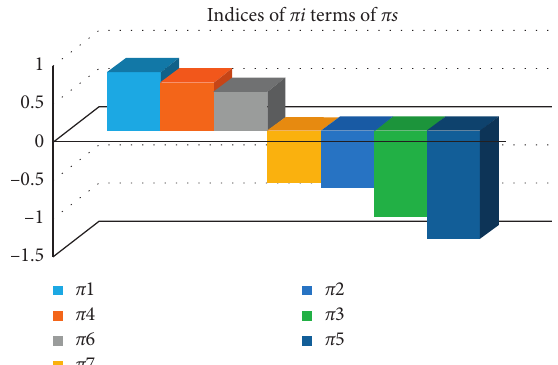
Figure 5: Indices of terms for π